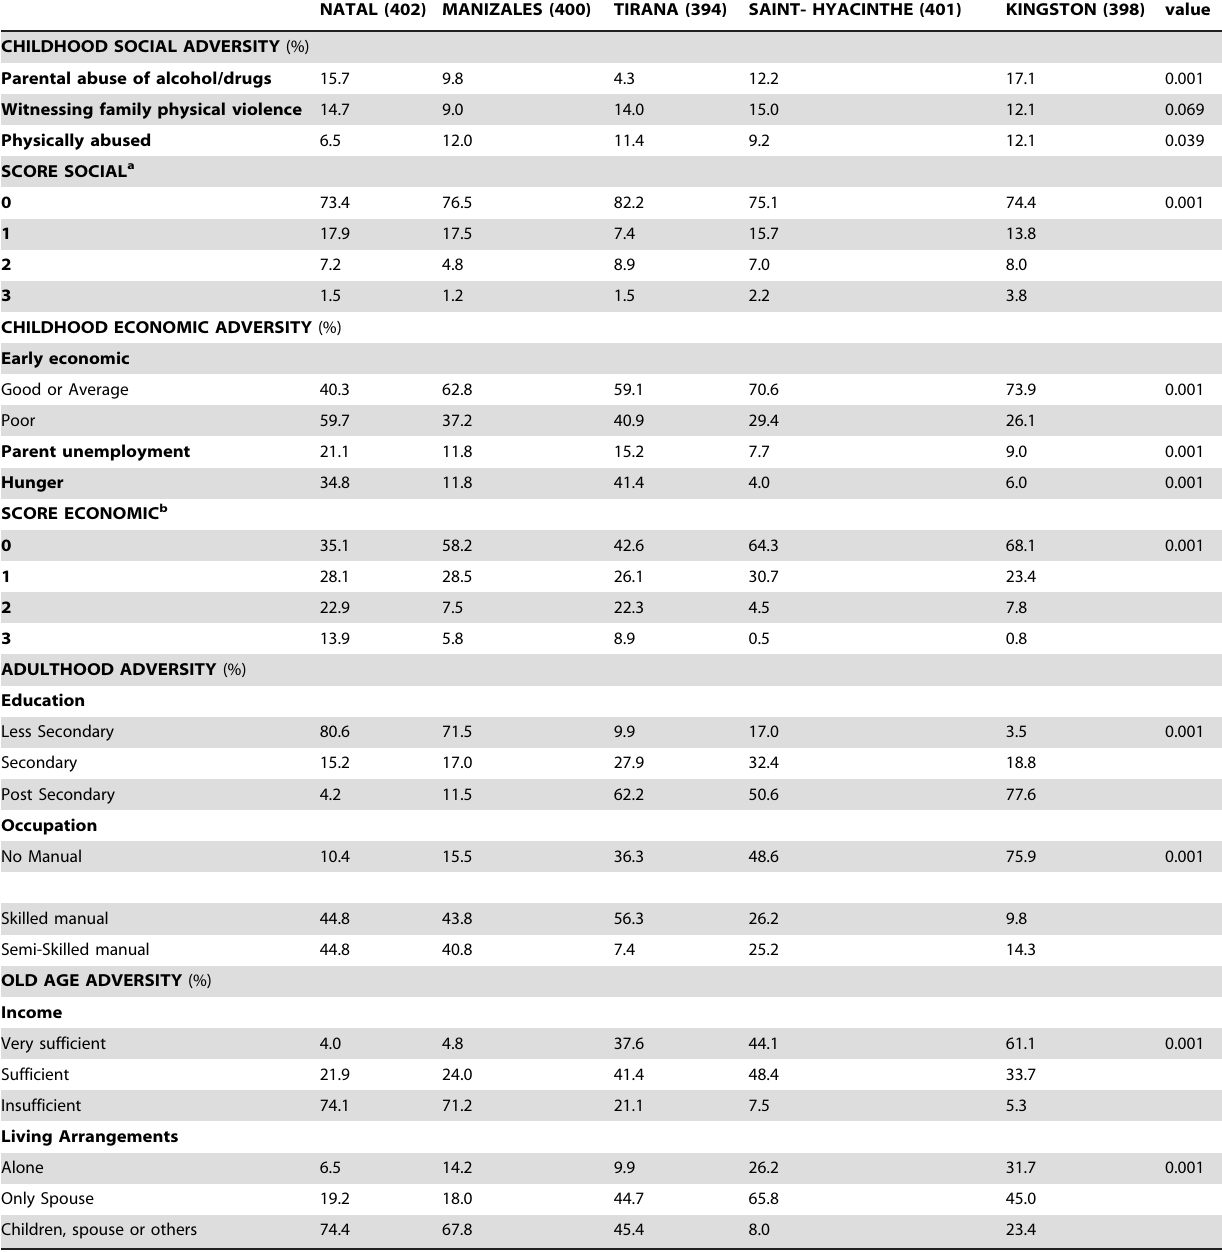
Table 1. Lifecourse Adversity By Research